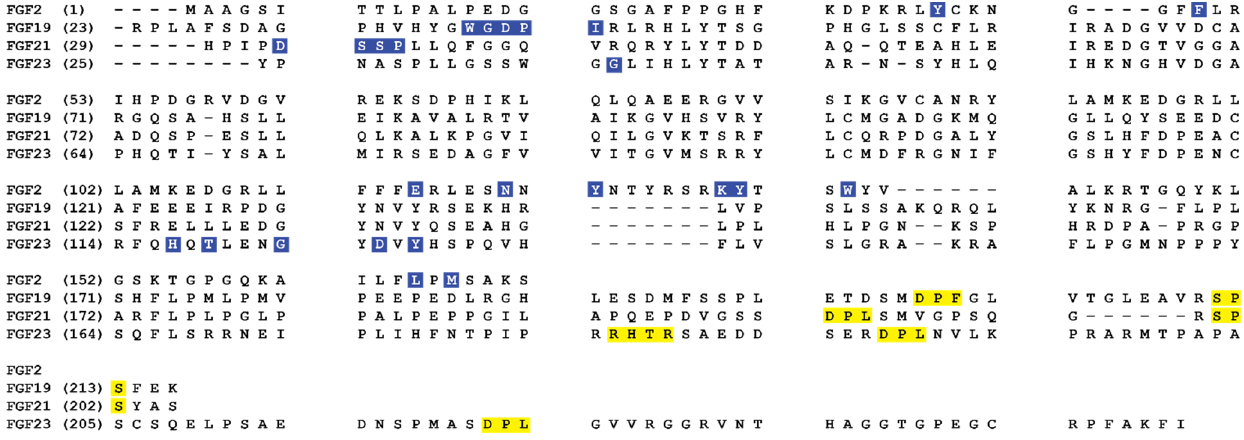
Figure 3. Multiple sequence alignments of human FGF2, FGF19, FGF21, and FGF23. The FGFR binding residues (blue) and klotho binding residues (yellow) are highlighted.